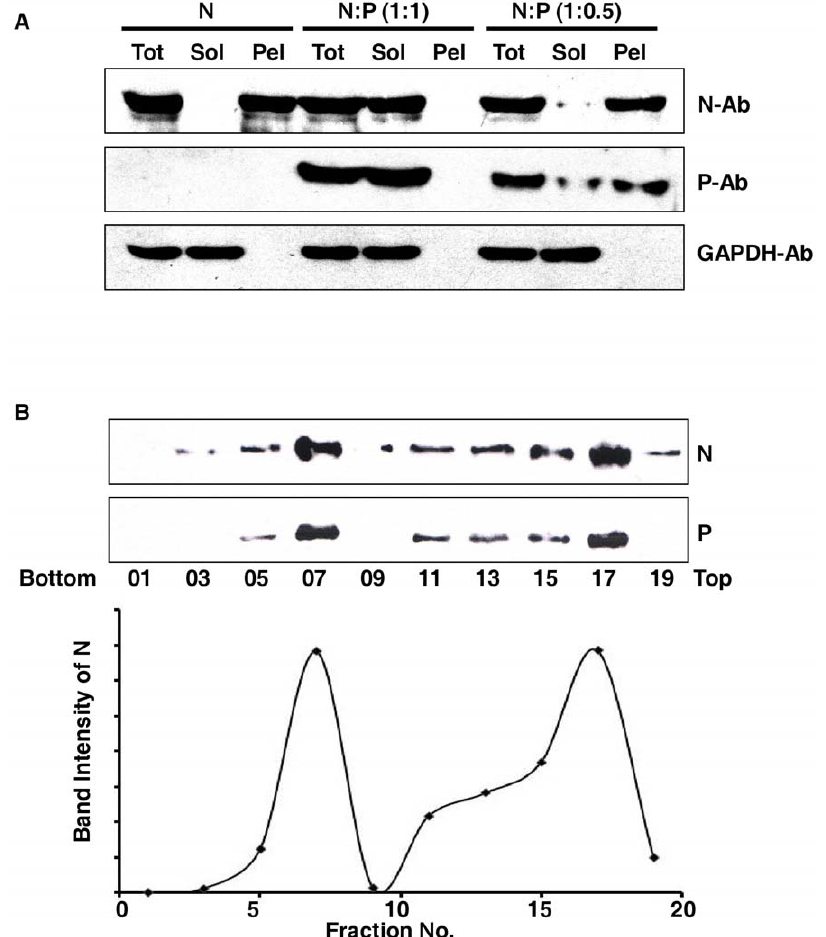
Figure 2. Soluble-insoluble fractionation and sucrose density gradient centrifugation. Stoichiometry of N and P ratio is important for the N specific chaperone activity of P. (A) Total (Tot), Soluble (Sol) and Insoluble (Pel) fractionation of Vero-76 cells transfected with different ratios of pEGFP-C1 N and pCDNA 3.1 ( + ) P at 24 hours post-transfection. N and P proteins were detected by immunoblotting with N and P Ab respectively. It is evident that a 1:0.5 N-P ratio is incapable of solubilising the otherwise insoluble N; however, a 1:1 ratio can do so. GAPDH was used as a loading control. (B) Oligomerization status of soluble N. Sucrose density gradient centrifugation of the soluble fraction of cells transfected with 1:1 ratio of GFP-N and P constructs. Fractions were collected from the bottom of the tube, and alternative fractions were immunobloted with N and P Abs.